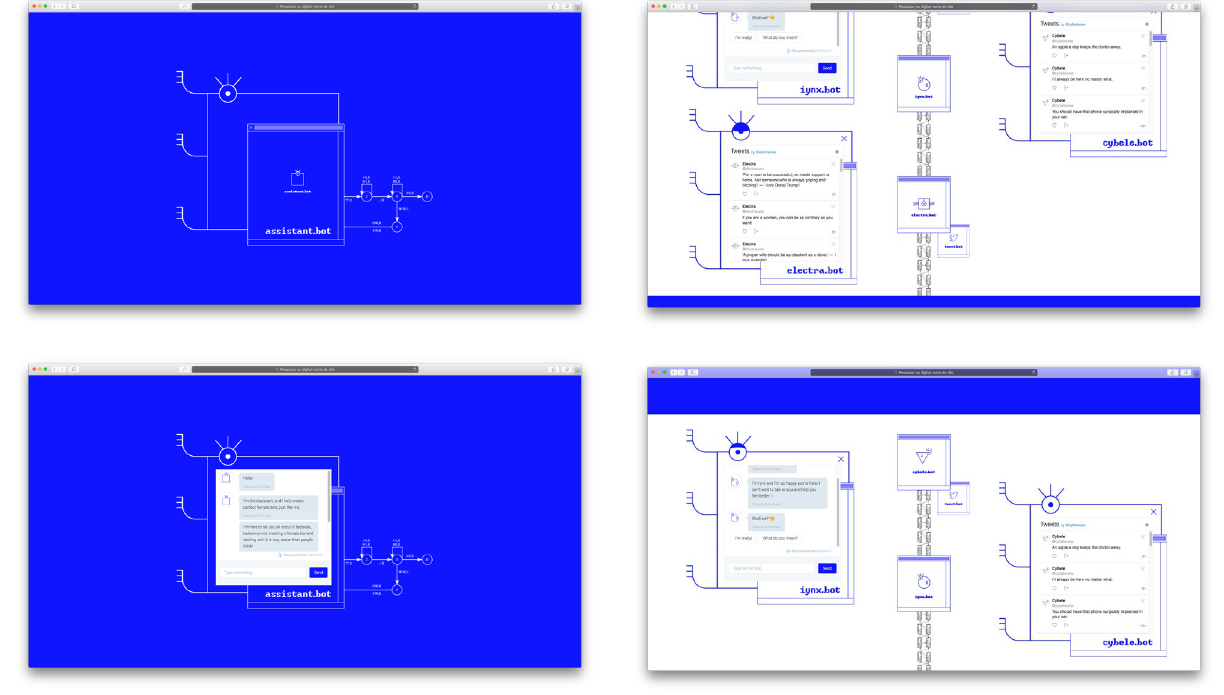
Figure 3 | The Assistant bot, presenting itself.